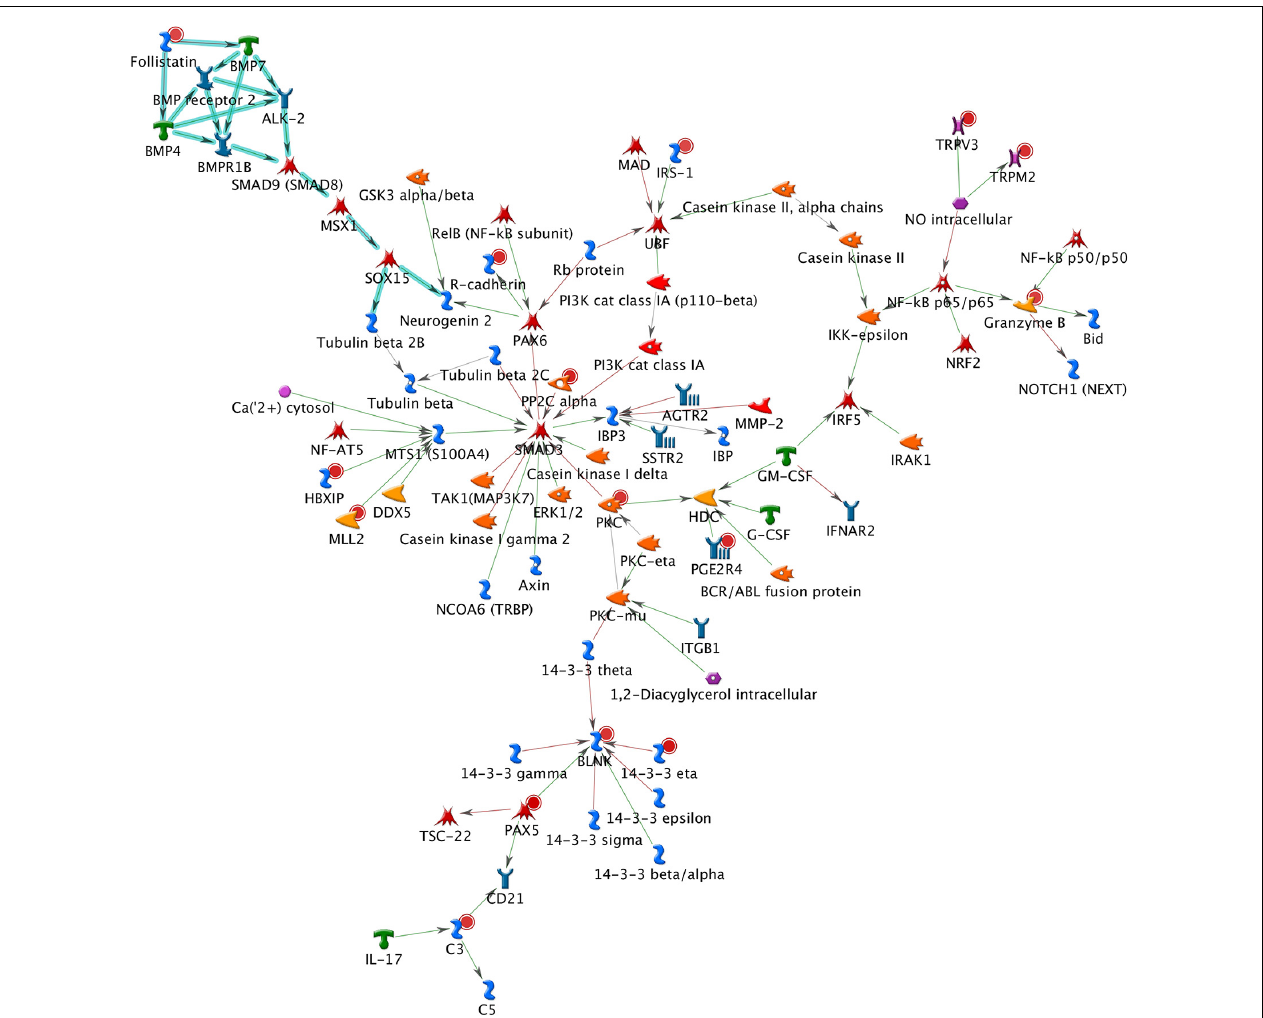
FIGURE 4 | The top two functional subnetwork. This subnetwork contained 15 objects and 83 interactions, which centered around six hubs, including three transcription factors (SMAD3, PAX6, and UBF), two generic binding proteins (BLNK and MTS1), and one generic enzyme (HDC). Thick cyan lines indicate the fragments of canonical pathways. Upregulated genes are marked with red circles and downregulated with blue circles. Green and red arrows indicate activation and inhibition effect,